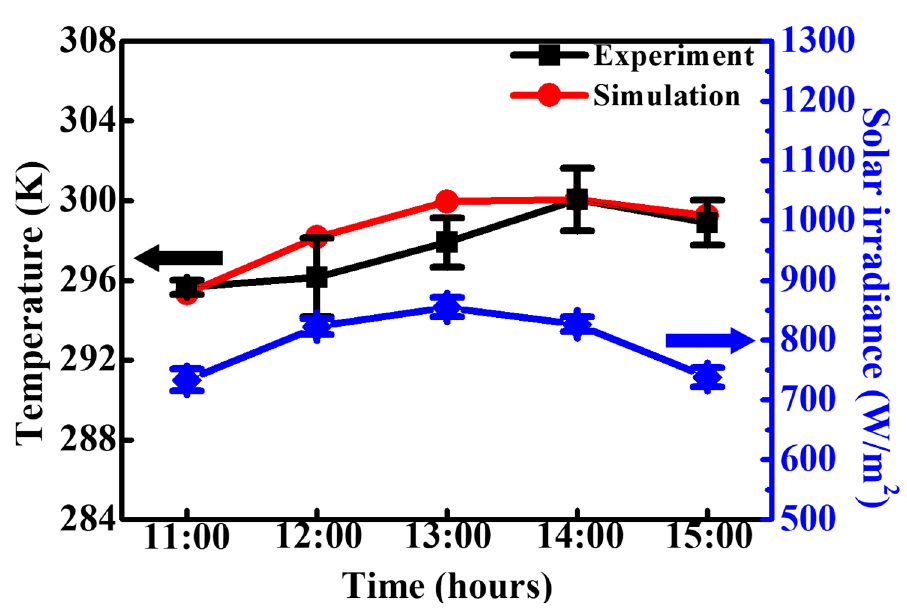
Figure 4. Temperature of discharged air from the solar air heater was measured during a typical sunny day in April in South Korea and compared with simulation